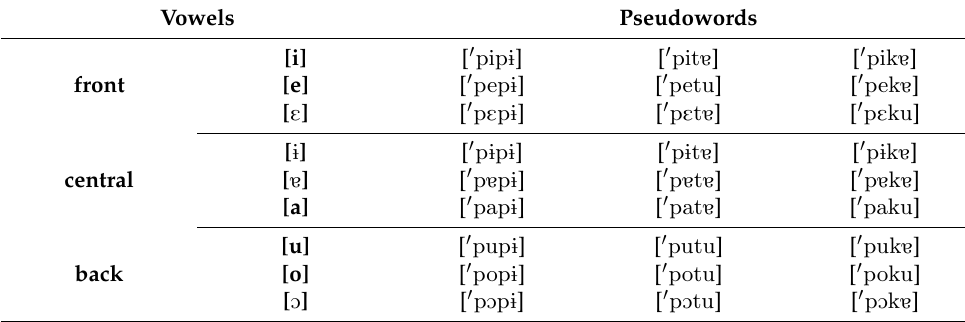
Table 2. List of pseudowords per vowel (International Phonetic